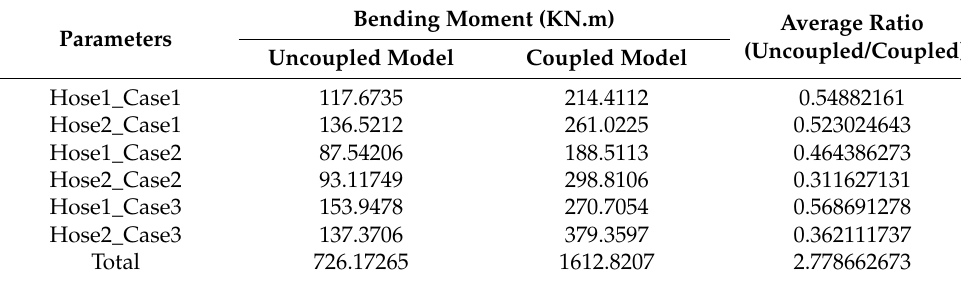
Figure 18. Validation study using the bending moment of the submarine hose, comparing the uncoupled and coupled models. Table 12. Validation study using the bending moment of the submarine hose.